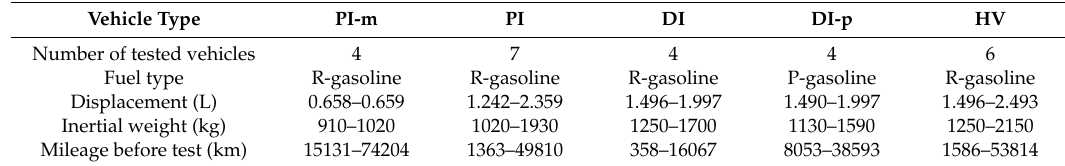
Table 1. Details of the vehicles tested in this study (R-gasoline: Regular gasoline, P-gasoline: Premium gasoline). The displacement, inertial weight, and mileage before the test exhibit the range of the tested vehicles. Vehicle Type PI-m PI DI DI-p